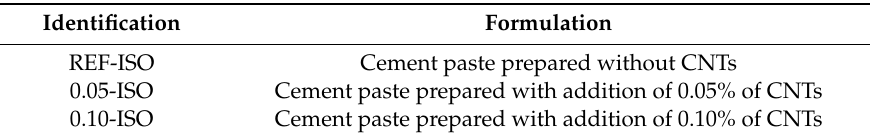
Table 1. Cement paste